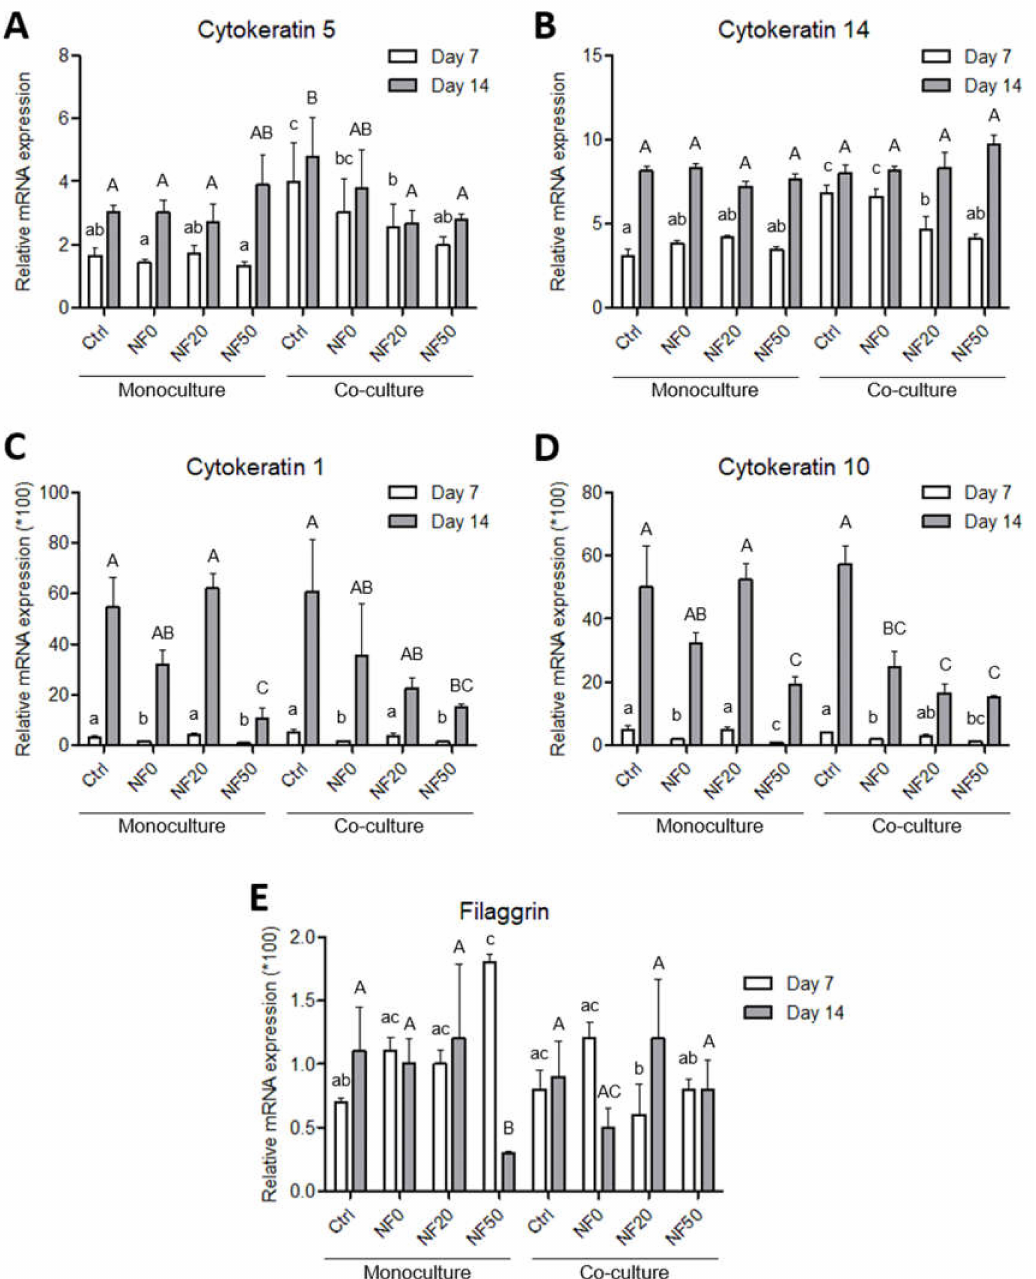
Figure 9. Quantification of the mRNA levels of the HaCaT in the monoculture and the co-culture with HSVEC. The relative expression of cytokeratin 5 ( A ), cytokeratin 14 ( B ), cytokeratin 1 ( C ), cytokeratin 10 ( D ) and filaggrin ( E ) on days 7 and 14 following seeding on the NF membranes. The target gene levels are expressed as relative values towards the reference B2M gene. The differing superscripts above the columns denote significant differences between the membranes that do not share the same superscript ( p < 0.05) for each cell culture type separately (monoculture and co-culture). The lower case letters denote significant differences on day 7, the upper case letters on day